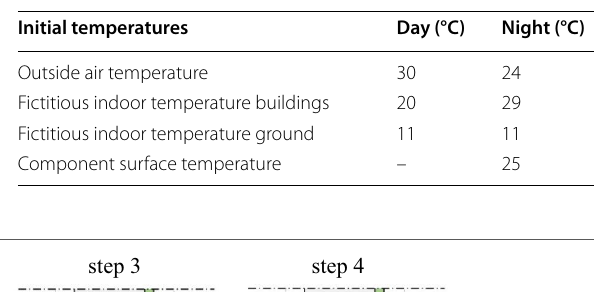
Table 1 Initial temperatures used within the one-dimensional model calculations